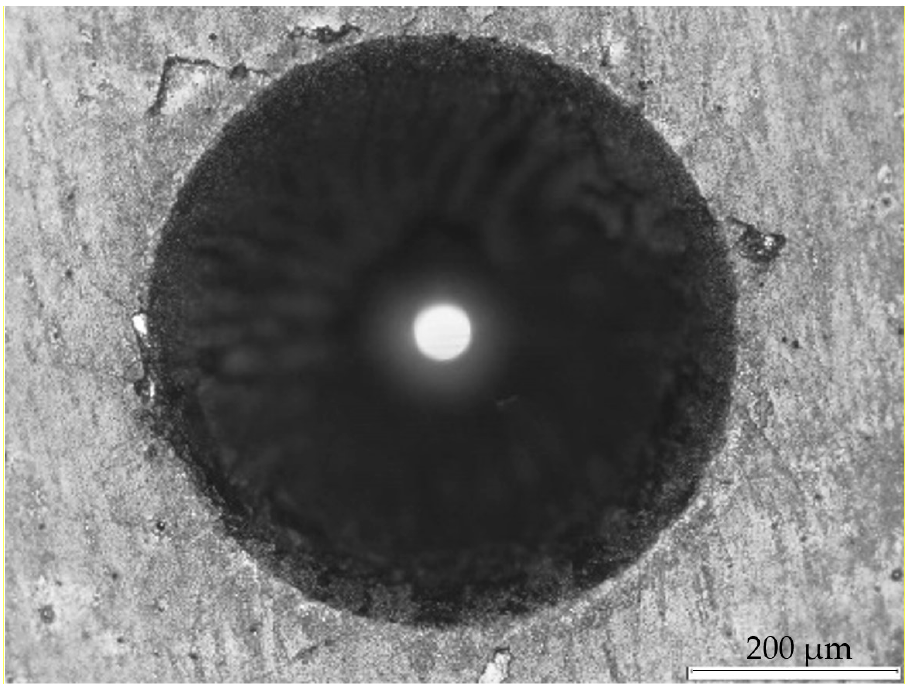
Figure 6. Rockwell-C indentation performed at the TiN film observed in optical microscope. Absence of severe cracks in the border are visible.